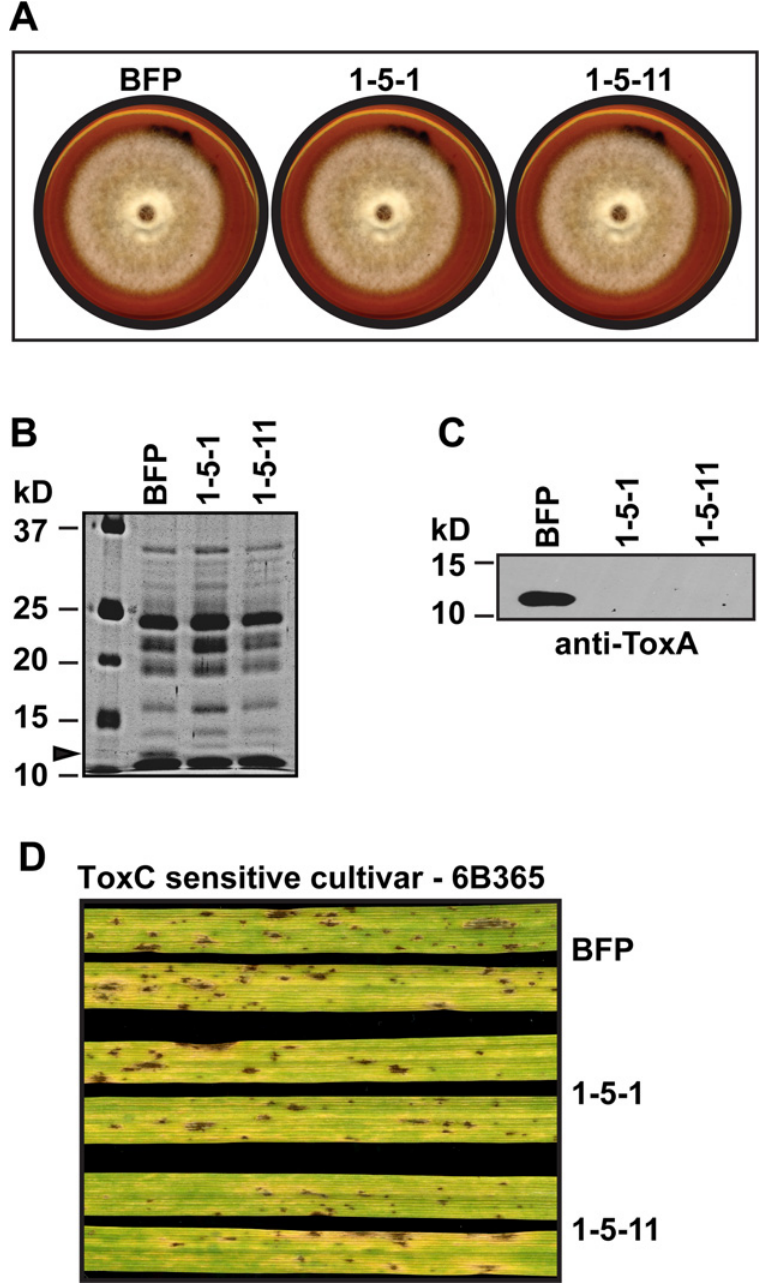
Fig 2. Characterization of growth and toxin production in BFP and BFP Δ toxA isolates. (A) Colonial morphology of isolates grown for 6 days on V8-PDA agar. SDS-PAGE of 20 μ l of crude culture filtrates either (B) silver-stained or (C) on western blot with anti-ToxA antisera. The molecular mass of standards and their position are indicated on the left of each gel. The arrowhead indicates the mobility of ToxA in the BFP crude culture filtrate. (D) Inoculation of isolates on the ToxC-sensitive cultivar ‘ 6B365 ’ . Leaves were harvested 5 days post inoculation.